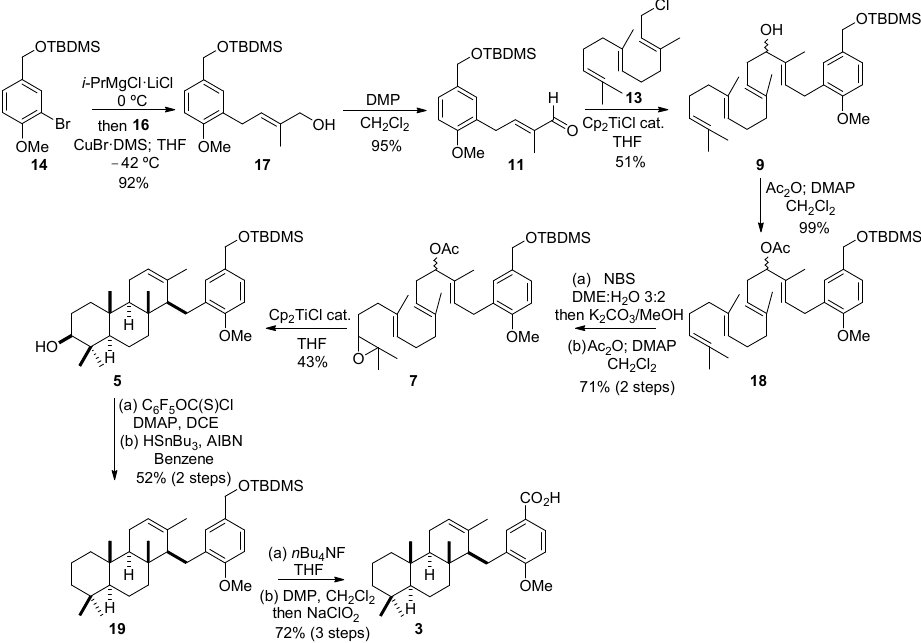
Scheme 2. Total synthesis of meroterpene 3 using titanocene(III)-catalyzed